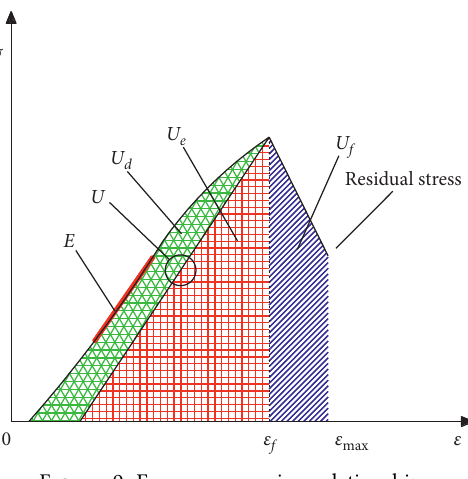
Figure 9: Energy conversion relationship.